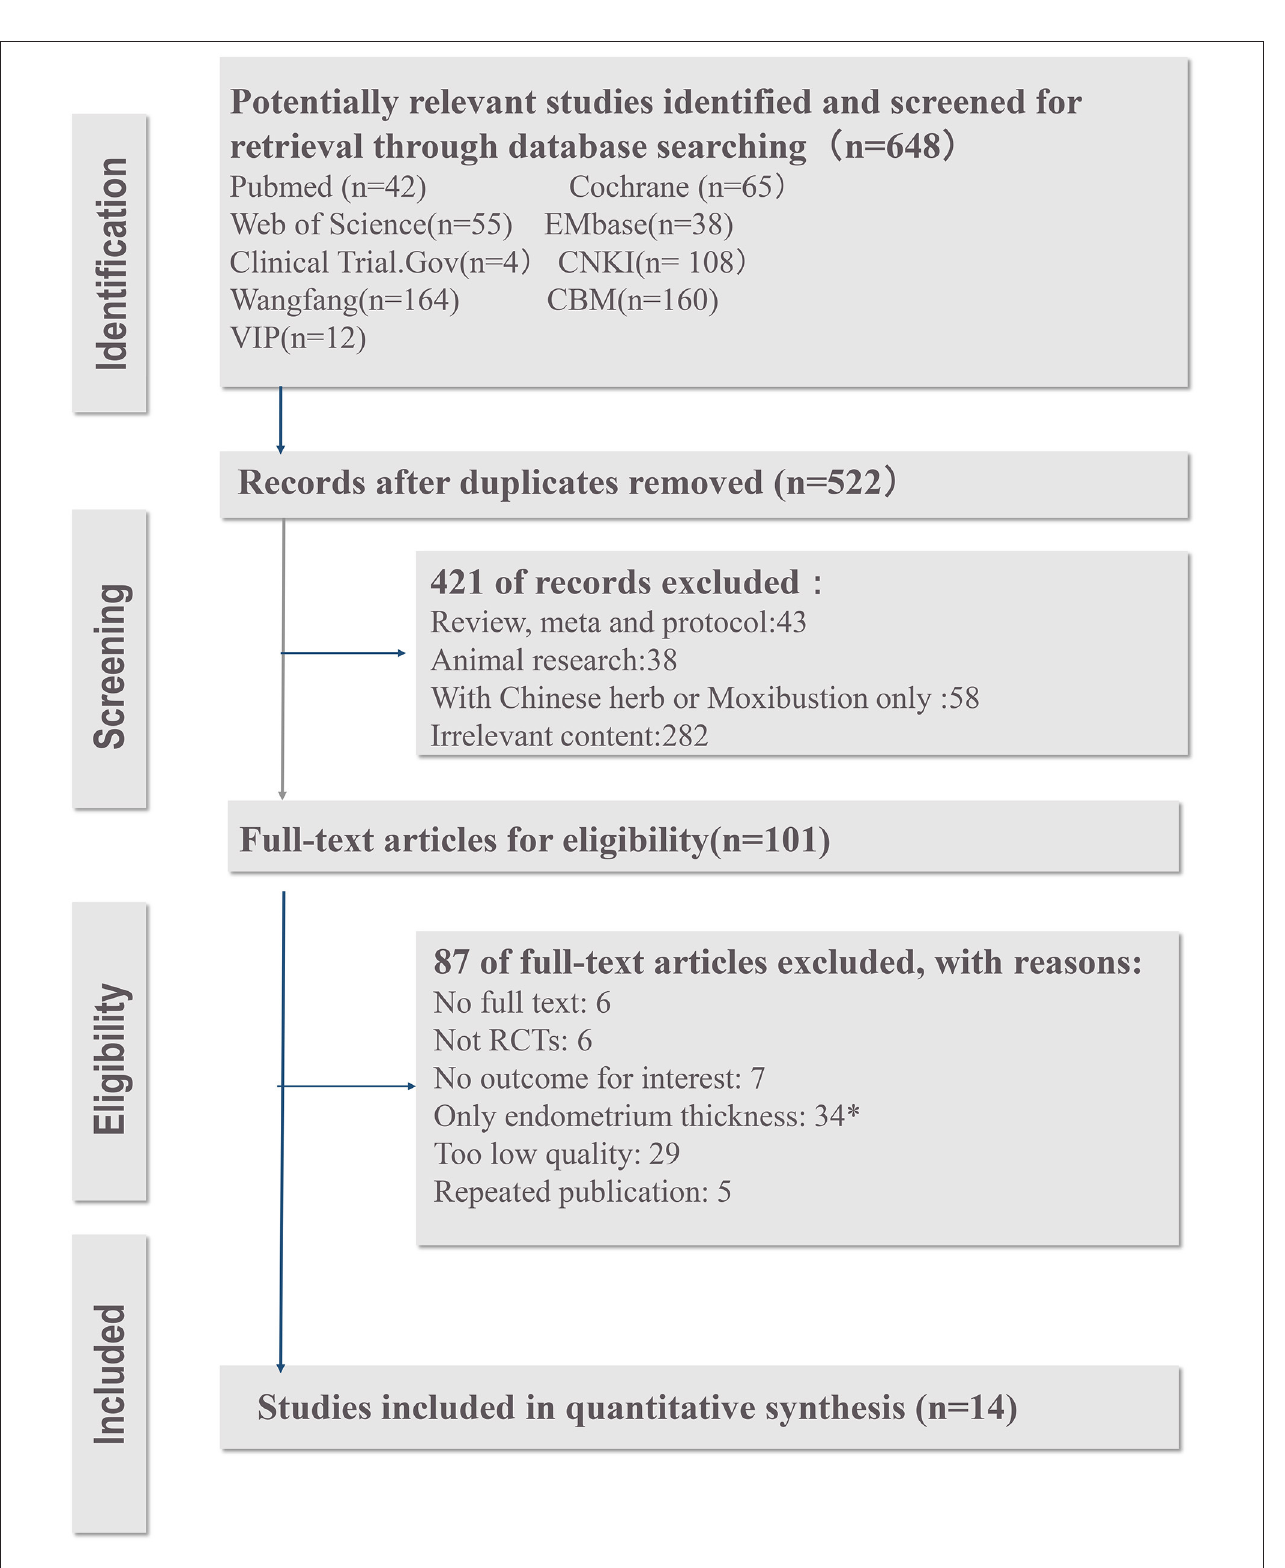
FIGURE 1 | The PRISMA flow diagram of study screening process. *The studies were excluded because that the utilization of EMT as a tool to decide on IVF cycle cancelation is not justified based on the current meta-analysis.